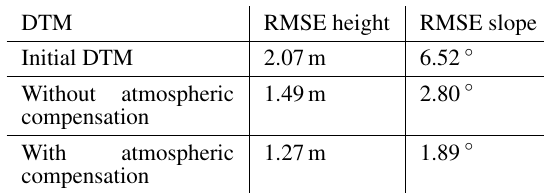
Table 2. Comparison of different DTMs to the HiRISE stereo DTM ground